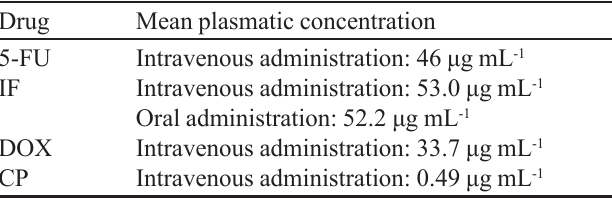
TABLE III - Mean plasmatic concentration of 5-fluorouracil (5-FU), ifosfamide (IF), doxorubicin (DOX) and cyclophosphamide (CP), according to Goodman & Gilman, 2006.